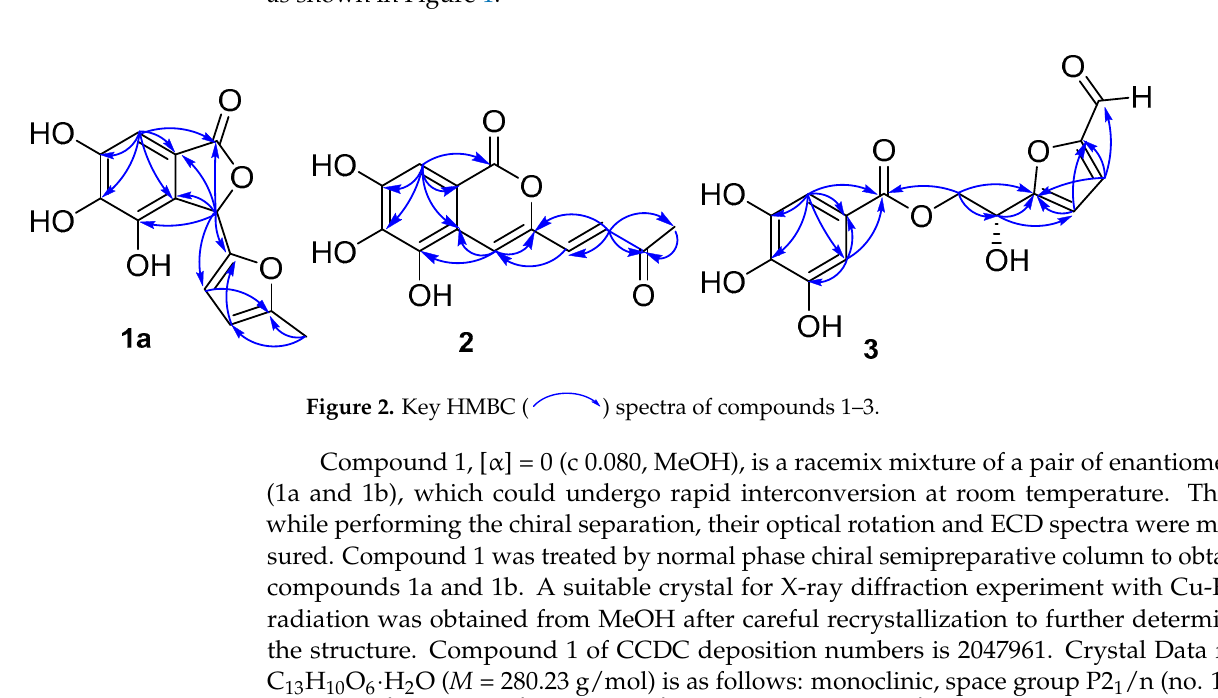
Figure 3. ( a ) The single-crystal spectrum of the enantiomers 1, ( b ) the ECD spectrum of compounds 1a and 1b.